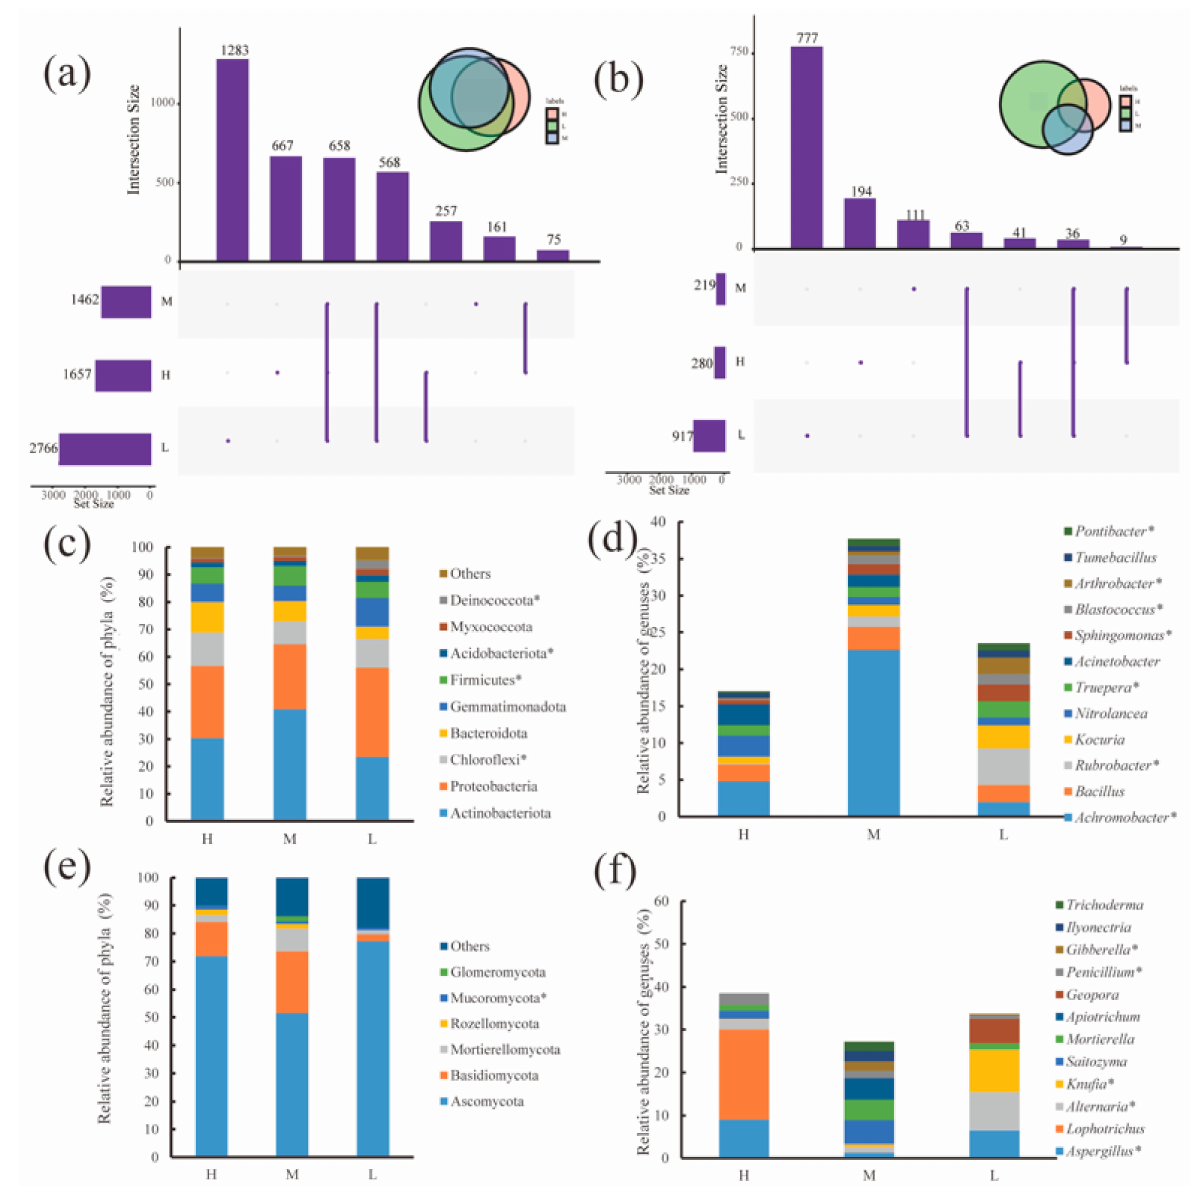
Figure 3. Distribution of microbial communities at the OTU, phylum and genus level under different water-salt gradients. Note: H, M and L denote high, medium and low water-salt gradients, respec- tively; ( a , c , d ) indicate the distribution of bacterial communities at the OTU, phylum, and genus levels, ( b , e , f ) indicate the distribution of the fungal communities at the OTU, phylum and genus levels. * indicates significant differences in microorganisms between groups ( p <